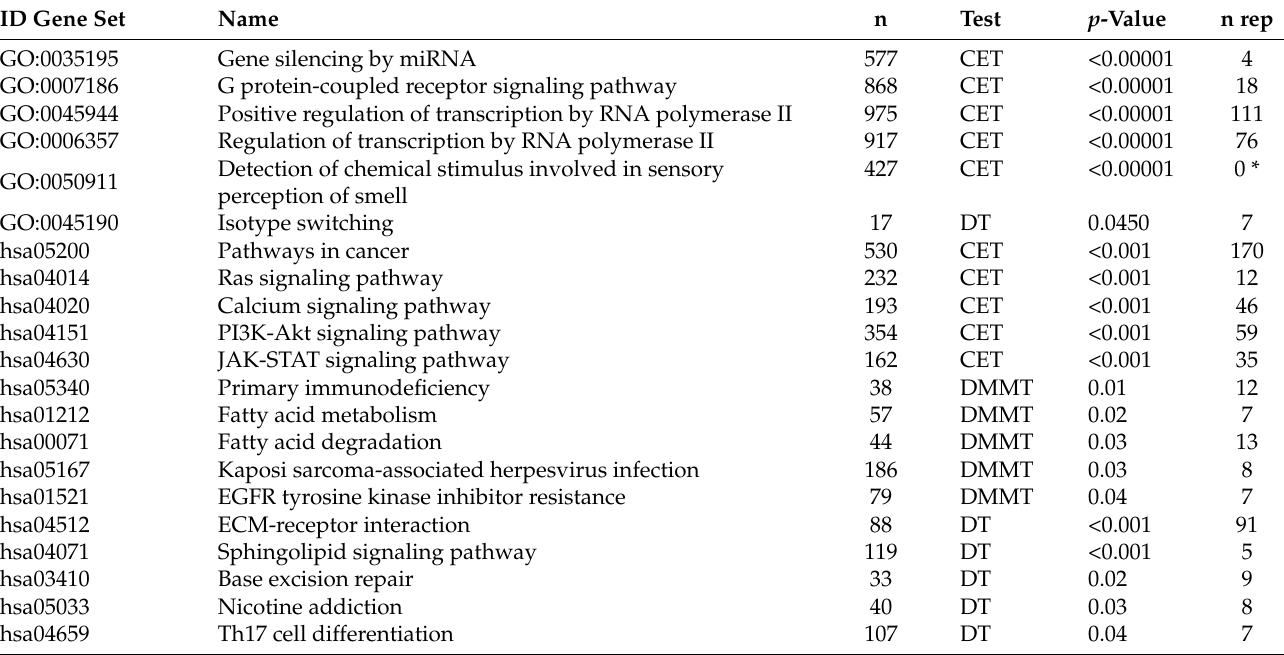
Table 1. Five gene sets with lowest p -values reported by each test using the between-pair distribution: CET, DMMT, and DT tests. The column headed “n” refers to the number of genes in the gene set. The number of papers “n rep” reporting the gene set association with Colorectal or Colonic Neoplasms have been obtained from the Comparative Toxicogenomics Database (GO terms) and MEDLINE bibliographic database (KEGG ID AND “colorectal cancer”). The asterisk * indicates that the gene set has been described as related to other cancer